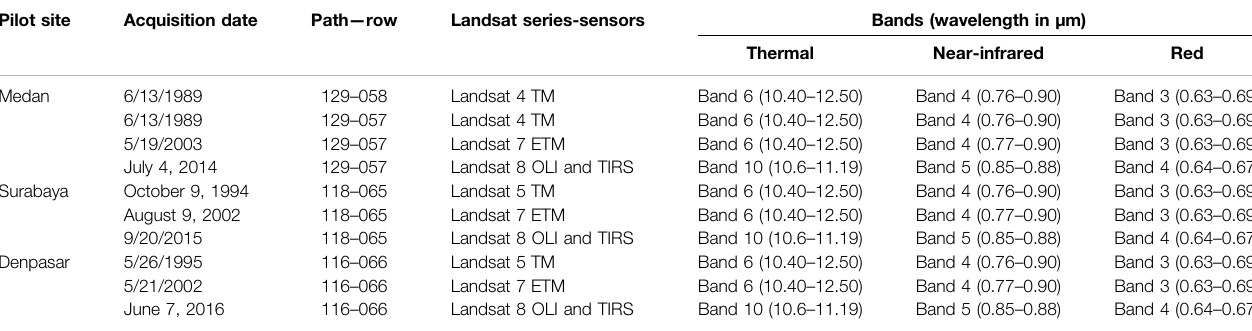
TABLE 1 | List of Landsat data over the study period.